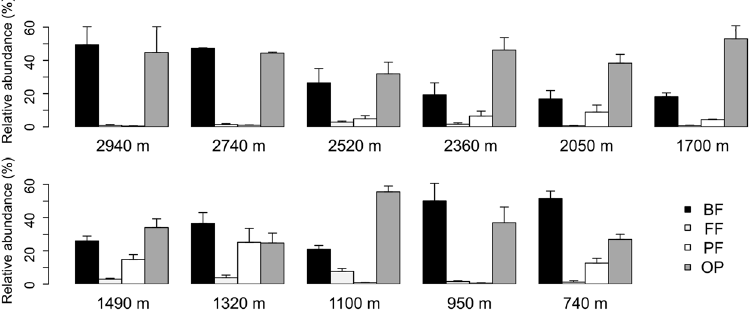
Figure 2. Relative abundance (%) of nematode feeding guilds at eleven different elevations. BF, bacteria feeding; FF, fungi feeding; PF, plant feeding; OP, omnivore/predator. Note the sum of the relative abundance of the four feeding groups is less than 100 percent, due to a sizeable proportion of unclassified